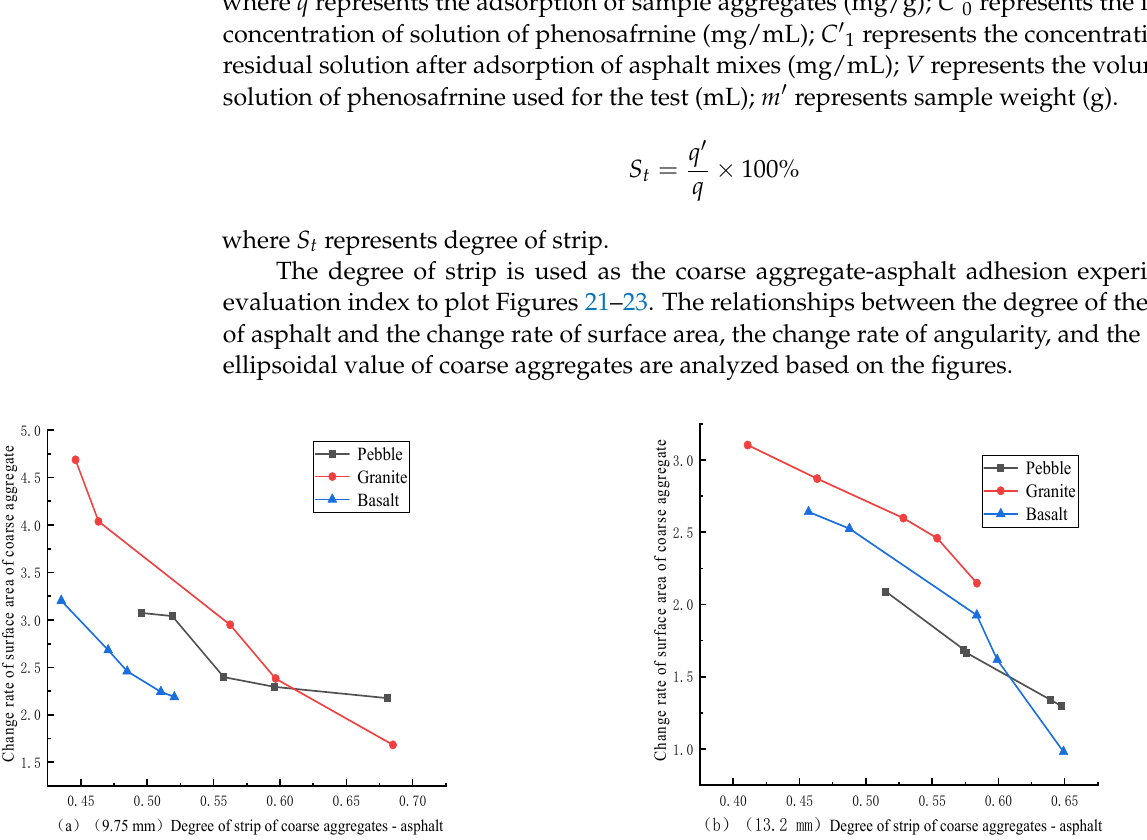
Figure 21. Relationship between degree of strip and change rate of surface area.